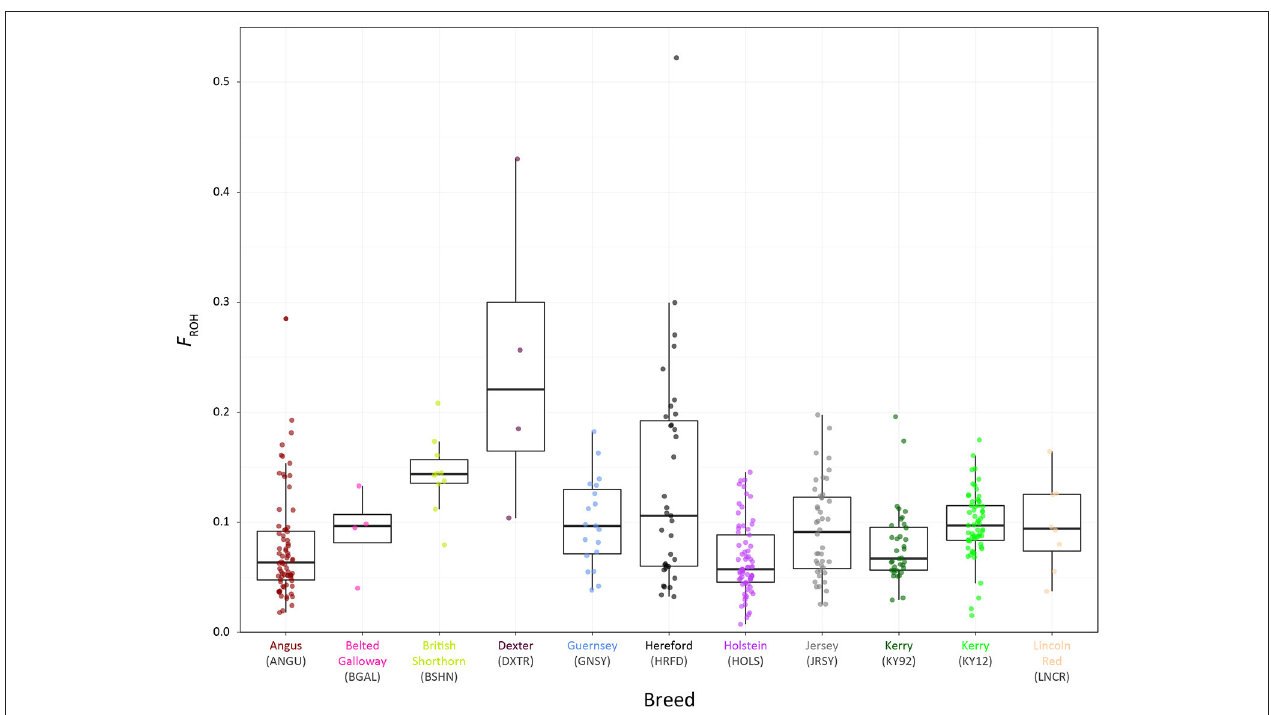
FIGURE 9 | Tukey box plots showing the distributions of F ROH values estimated with genome-wide SNP data for the KY92 and KY12 populations and nine comparator heritage and production cattle breeds.